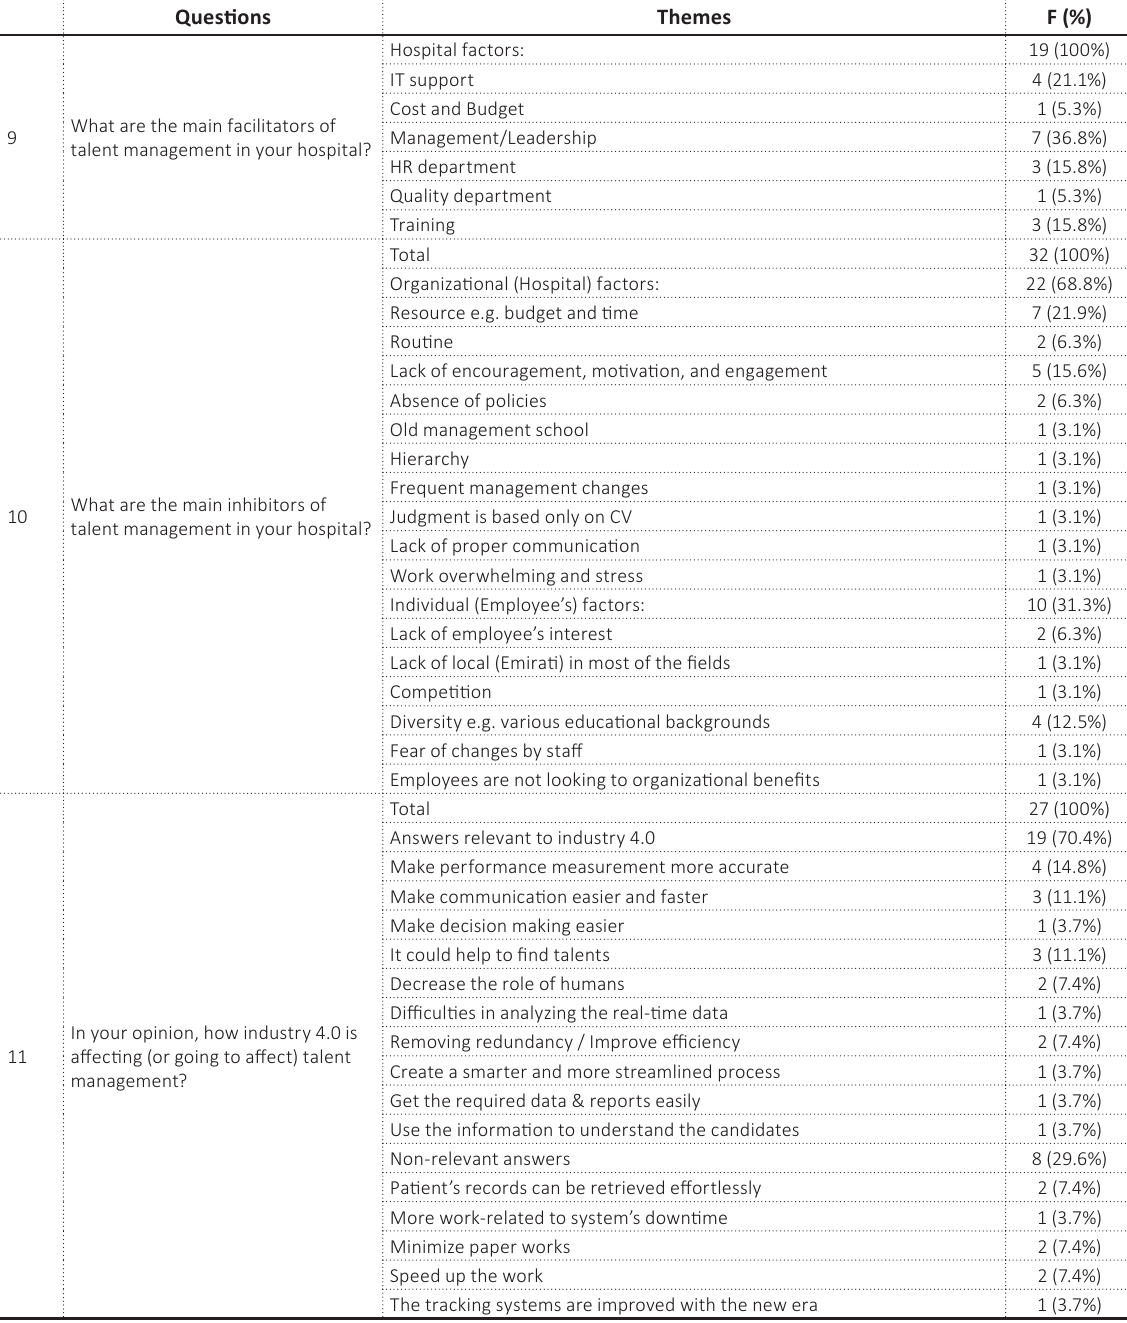
Table A1 (cont.). Thematic analysis of the survey’s